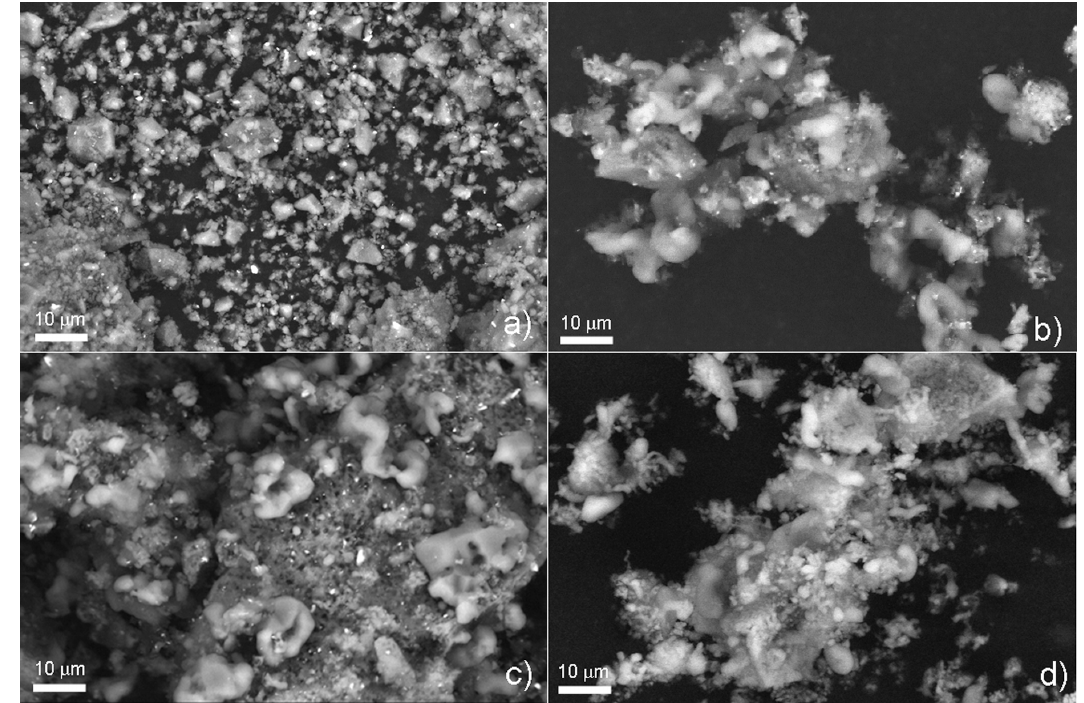
Figure 5. SEM-BSE images of 5 wt% Fe-doped MgH ( a ) 1 cycle; ( b ) 22 cycles and ( c ) 47 cycles at 300 °C; ( d ) SEM-BSE images of pure MgH ball milled for 10 h after 22 cycles, at 350 °C.